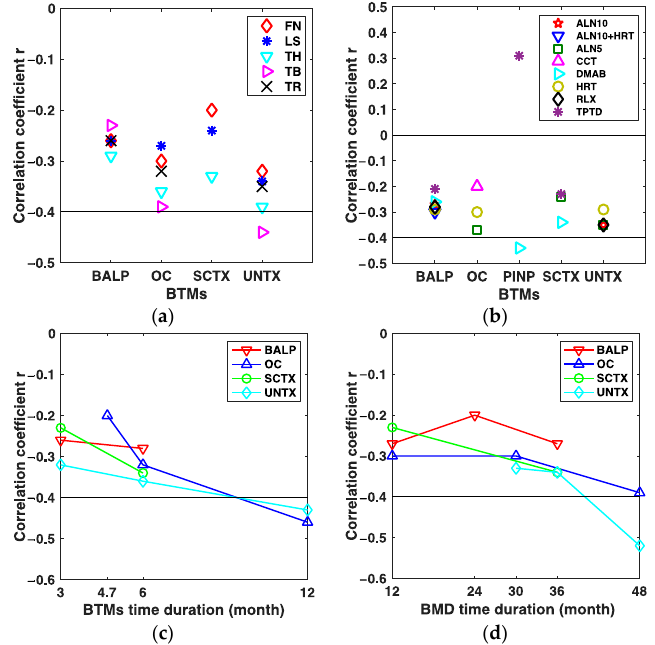
Figure 6. Assembled results of the subgroup analyses. ( a ) Assembled CORs between the changes in BTMs and BMD from baseline by group of bone sites. ( b ) Assembled CORs between the changes in BTMs and BMD from baseline by group of drug intervention. ( c ) Assembled CORs between the changes in BTMs and BMD from baseline by group of the time duration of BTMs measurements. ( d ) Assembled CORs between the changes in BTMs and BMD from baseline by group of the time duration of BMD measurements. ALN alendronate, ALN5 5 mg/d ALN, ALN10 10 mg/d ALN, ALN10+HRT, combination of 10 mg/d ALN and HRT, CCT calcitonin, COR summary correlation coefficient r , DMAB denosumab, HRT hormone replacement therapy, RLX raloxifene, TPTD teriparatide, FN femoral neck, LS lumbar spine, TB total body, TH total hip, TR